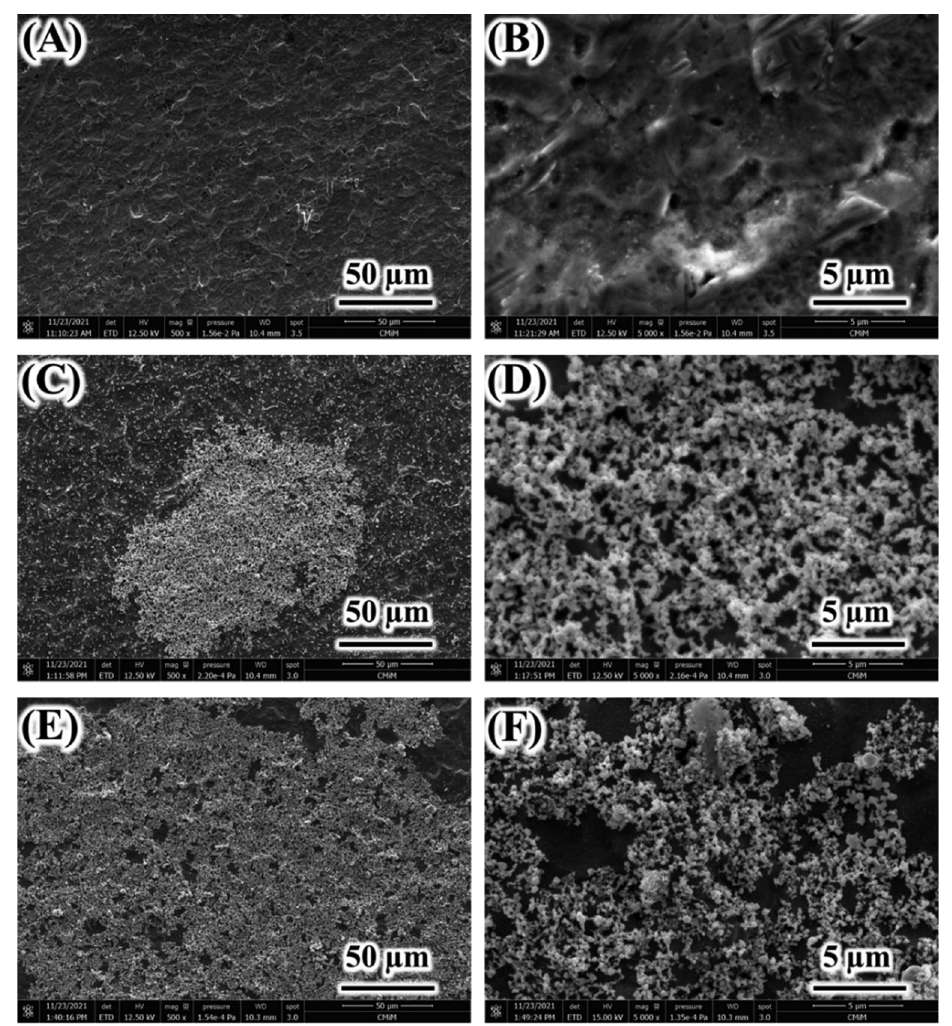
Figure 2. Scanning electron microscope images of untreated Ti (A and B), Ag coated Ti from 0.01 mol/L AgNO 3 (C and D), and Ag coated Ti from 0.1 mol/L AgNO 3 (E and F).